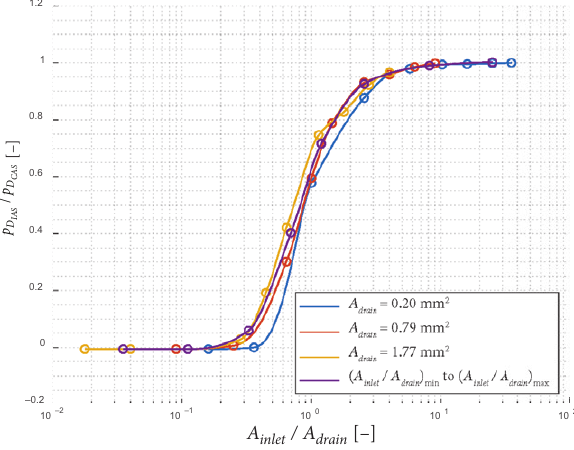
p p ratio on IAS CAS D D